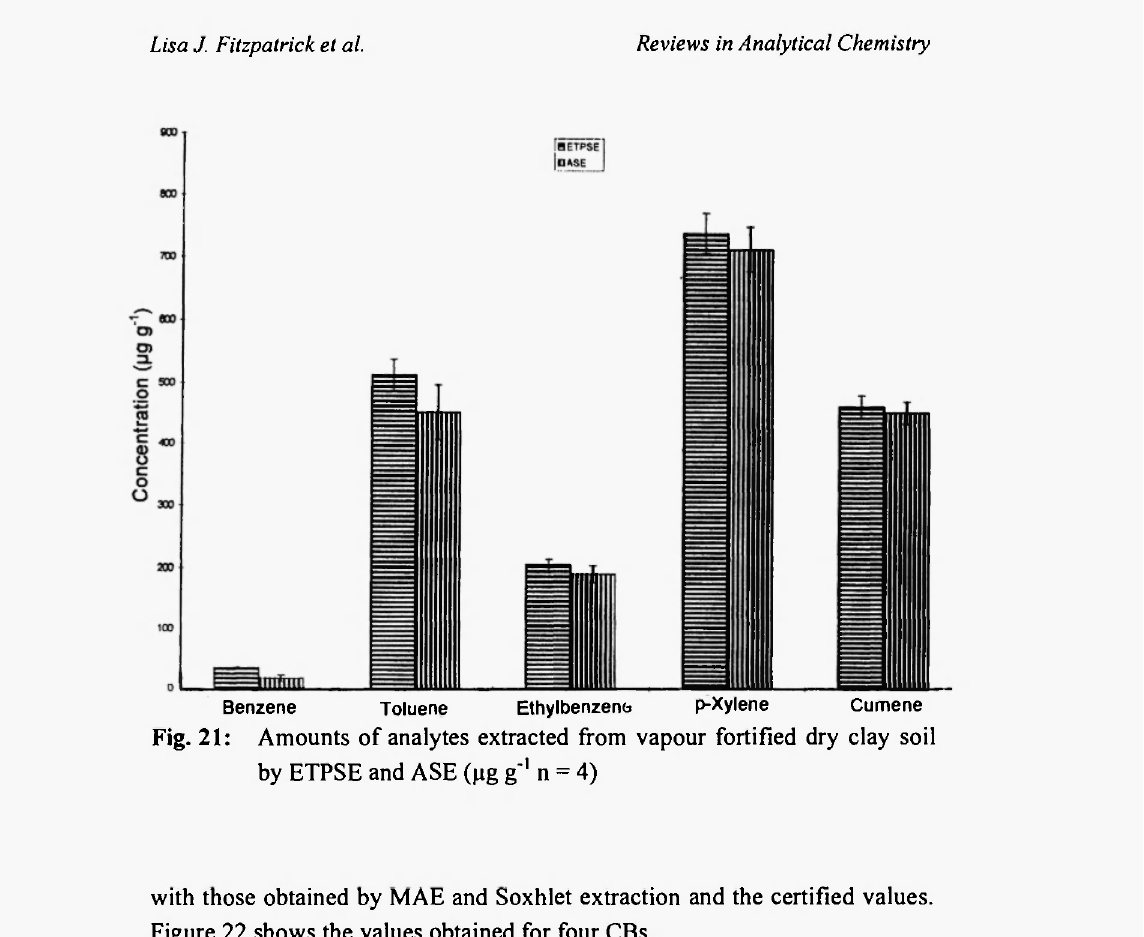
with those obtained by MAE and Soxhlet extraction and the certified